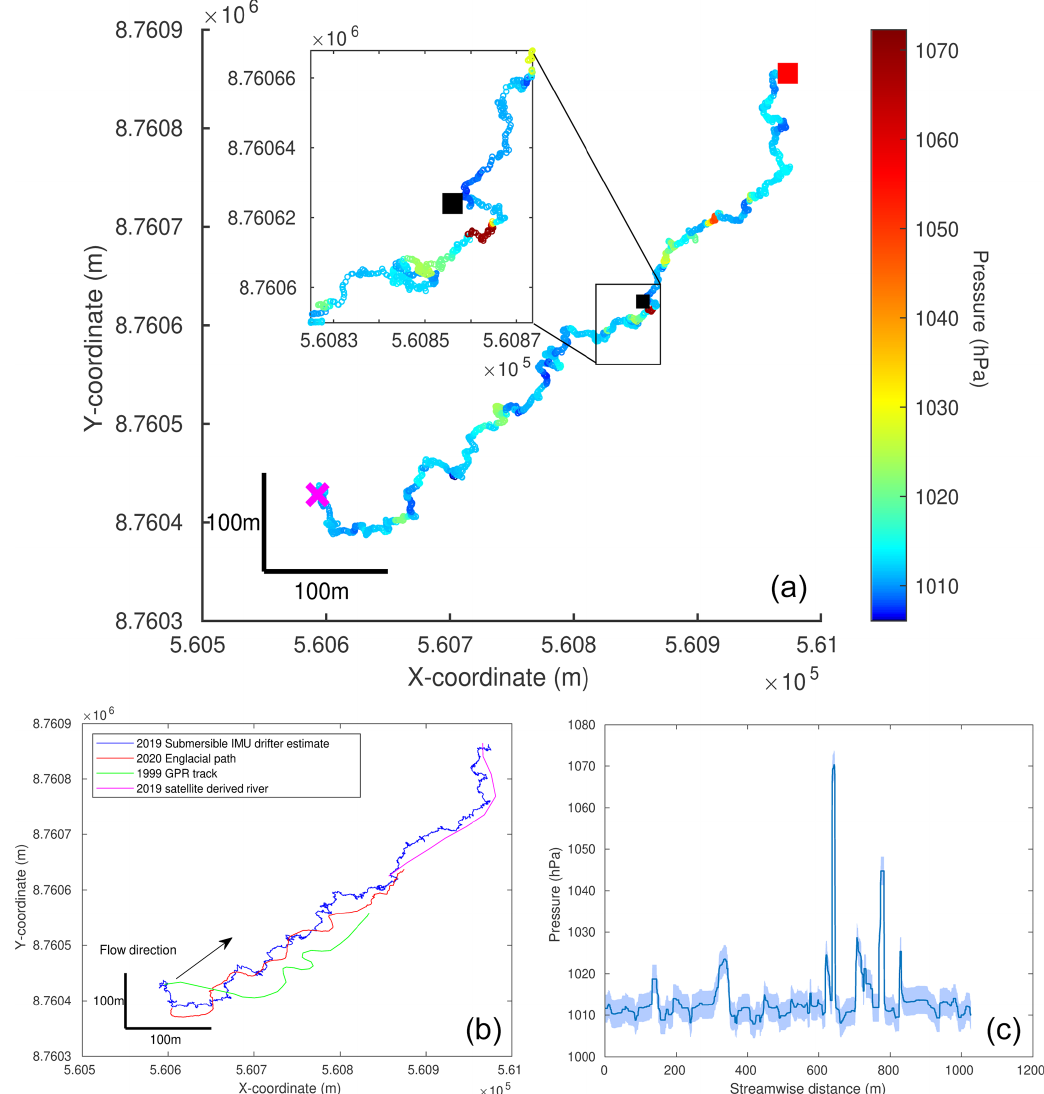
Figure 7. Englacial channel reconstruction. (a) Estimated average track of the englacial channel in UTM coordinates with pressure distri- bution in hectopascals. The deployment is marked with a pink cross, and the recovery is a red square. Additionally shown is the location of the start of the canyon at the end of the englacial channel (black square). (b) Estimated englacial track in UTM coordinates based on the 2019 IMU data in blue alongside a GNSS drifter reference measured in 2020 in red. Further shown are the mapped canyon and proglacial river from optical Planet imagery (acquisition date: 9 July 2019; Team Planet, 2017), as well as the 1999 GPR map traced from Stuart et al. (2003). (c) Average water pressure with standard deviation along the estimated streamwise distance of the englacial